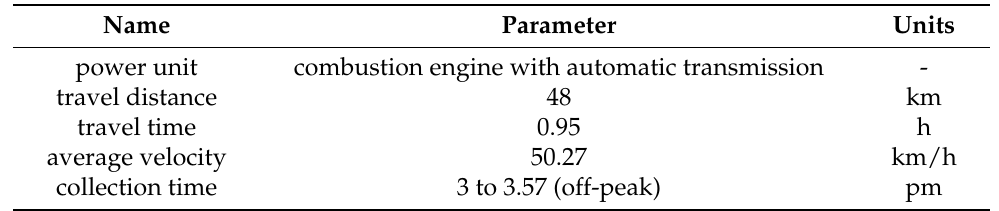
Table 1. Information of data collection.